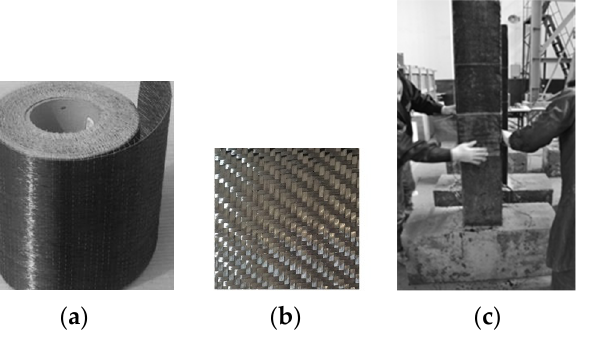
Figure 3. ( a ) A roll of fiber sheets. ( b ) Shape of the basalt fiber sheet. ( c ) bonding between BFRP and corroded concrete column.